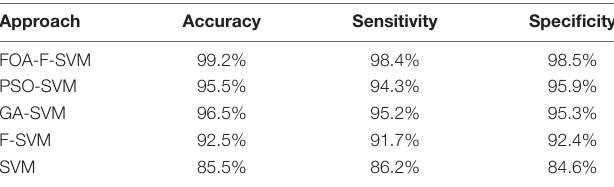
TABLE 7 | Classification accuracy of the comparison among FOA-F-SV, PSO-SVM, GA-SVM, F-SVM, and